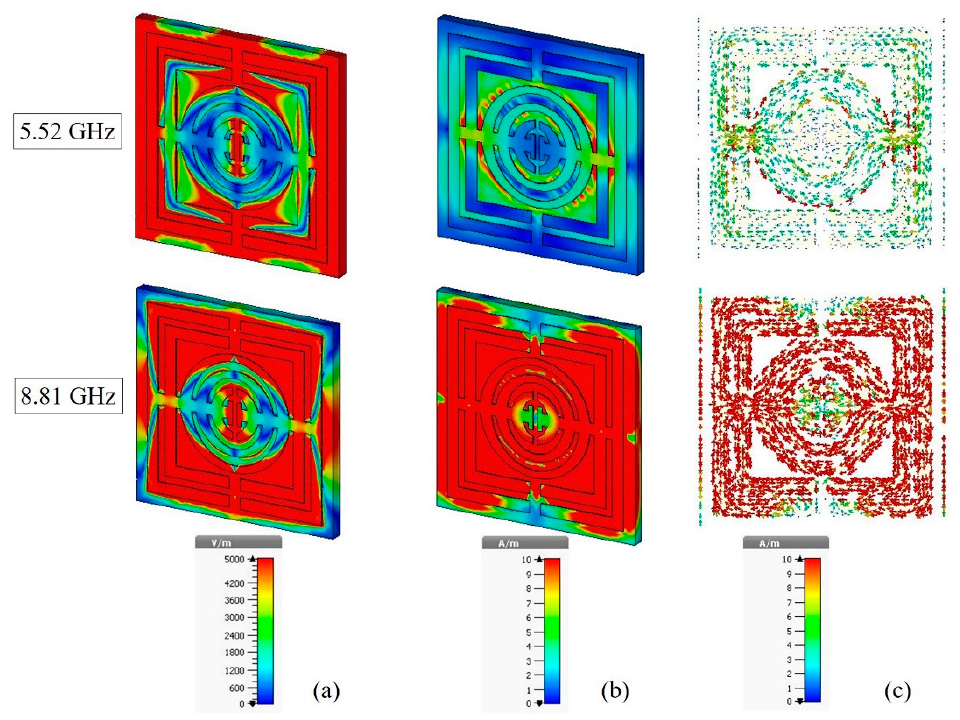
Figure 7. ( a ) Electric field, ( b ) magnetic field, and ( c ) surface current distribution.